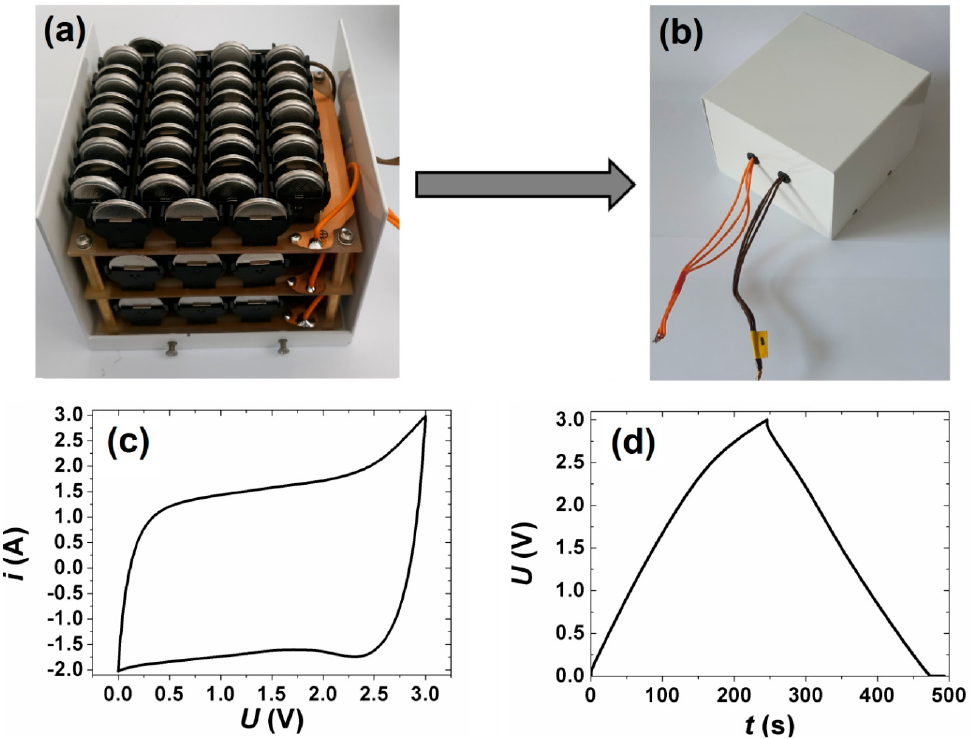
Figure 3. Inside ( a ) and outside ( b ) view on 60 F supercapacitor module, ( c ) cyclic voltammetry (at 0.03 V s − 1 ) and ( d ) GCPL (at 0.85 A) characteristics of a module.